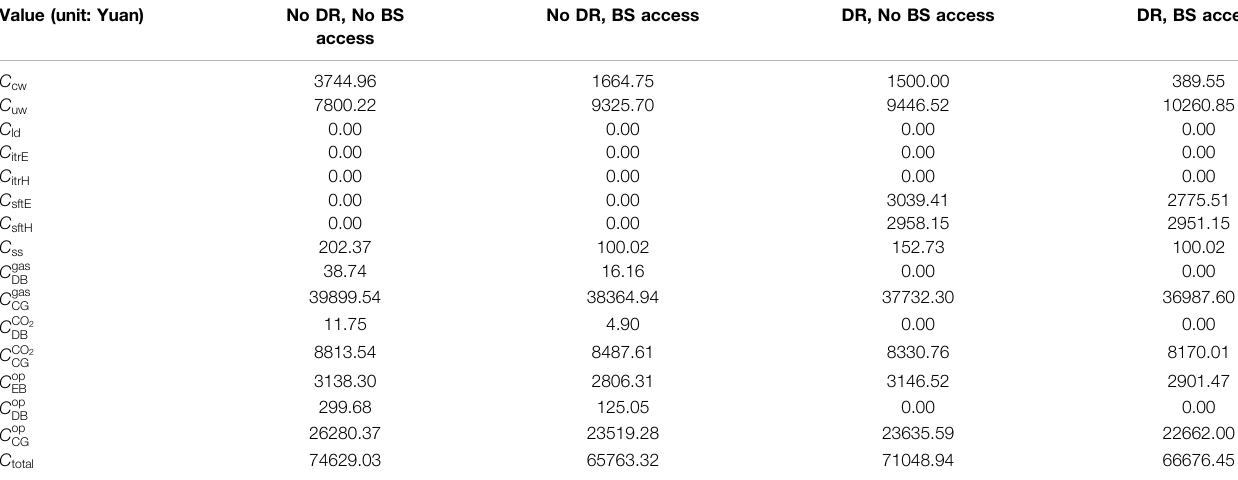
TABLE 3 | Comparison of cost items of optimized dispatching plans under various scenarios.